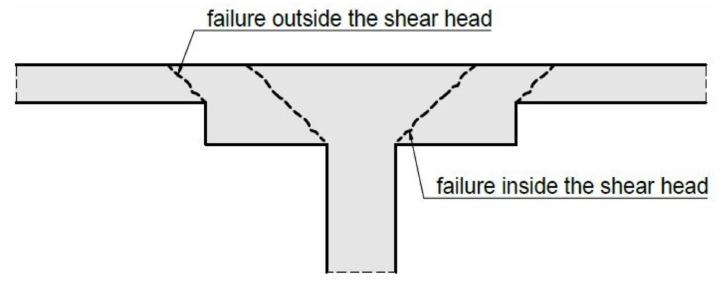
Figure 1. A column topped with a shear cap showing potential failure